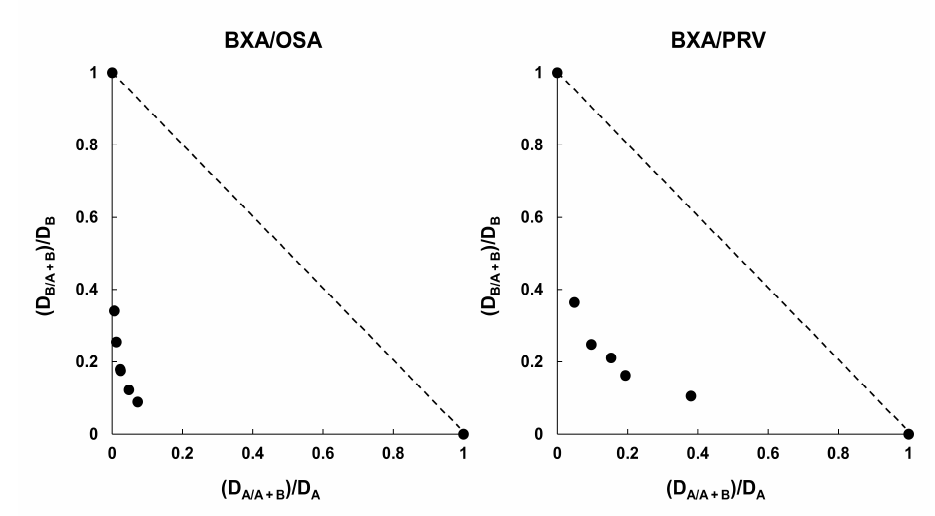
Figure 4. The isobologram plot of baloxavir acid (BXA) combined with oseltamivir acid (OSA) or peramivir trihydrate (PRV). The 50% effective concentration (EC 50 ) of each substance alone and at a fixed concentration were determined. (D A / A+B )/D A and (D B / A+B )/D B were plotted on the x- and y-axes, respectively. D A is the EC 50 of substance A alone, D B is the EC 50 of substance B alone, D A/A+B is the concentration of substance A; given a 50% inhibition combined with substance B, D B/A+B is the concentration of substance B; given a 50% inhibition combined with substance